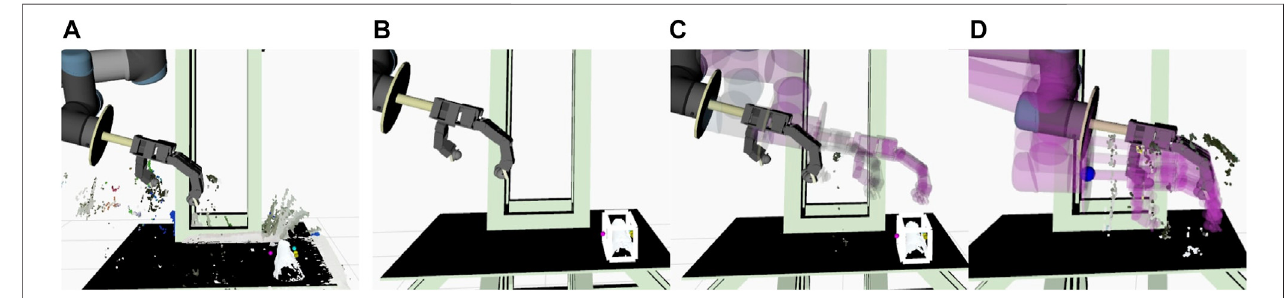
FIGURE 2 | Methodology for the haptic exploration. (A) Point cloud data of the workspace. (B) The bounding box of the object extracted. (C) First step of path planning:towardsalocationata fi xeddistanceovertheobjectboundingbox. (D) Secondstepofpathplanning:loweringdownandenclosingthe fi ngersontheobjectto compute the grasp